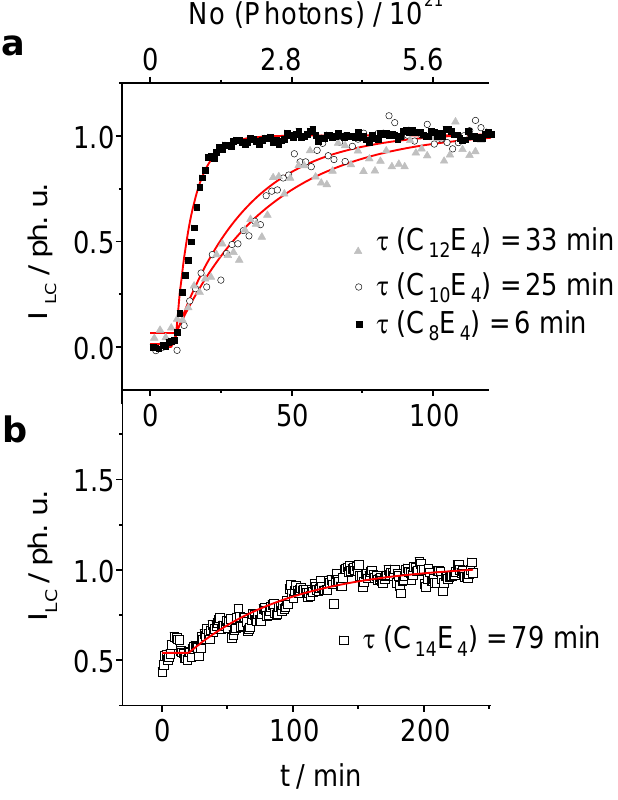
Figure 5. The normalized integral scattering intensity of the LC reflection exponentially increases as a function of irradiation time. The lifetime for the photo-transformation increases as the chain length of the system gets longer. ( a ): C For C E the temperature was set to a value where the system was already partially 14 4 transformed through thermal fluctuations leading to the creation of several LC